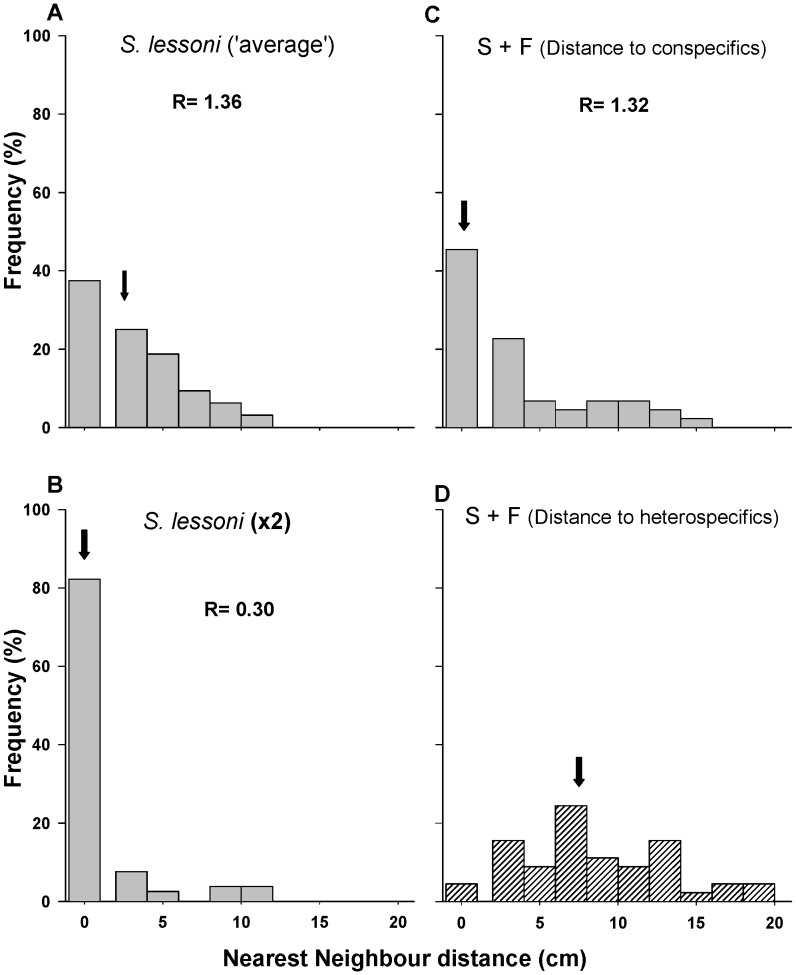
Nearest neighbor linear distances histogram for Siphonaria lessoni recorded in field experiments.Distances to conspecifics (a-c) and heterospecifics (d), in intraspecific enclosure treatments at natural (a) and double density (b), and in interspecific (c, d) enclosure treatments (i.e. distance from F. crassa). Arrows show the median value.